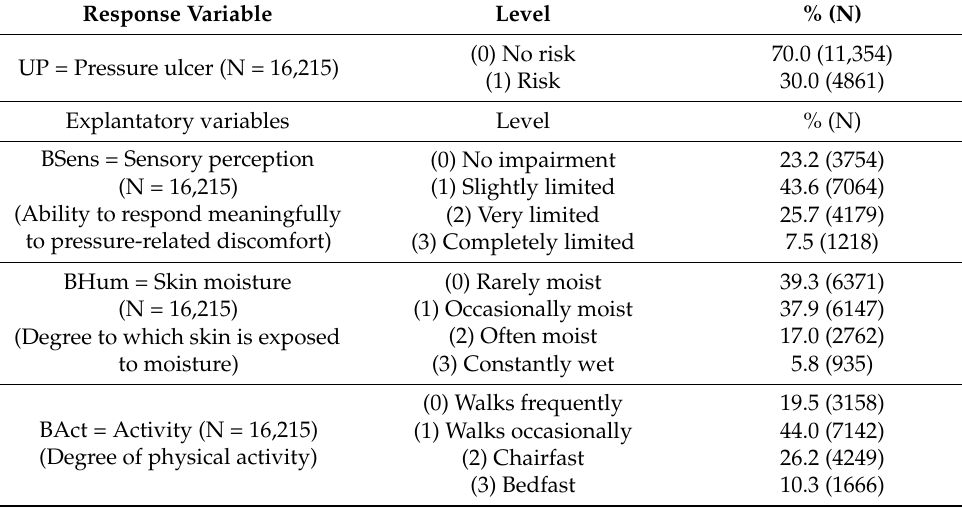
Table 1. Description of